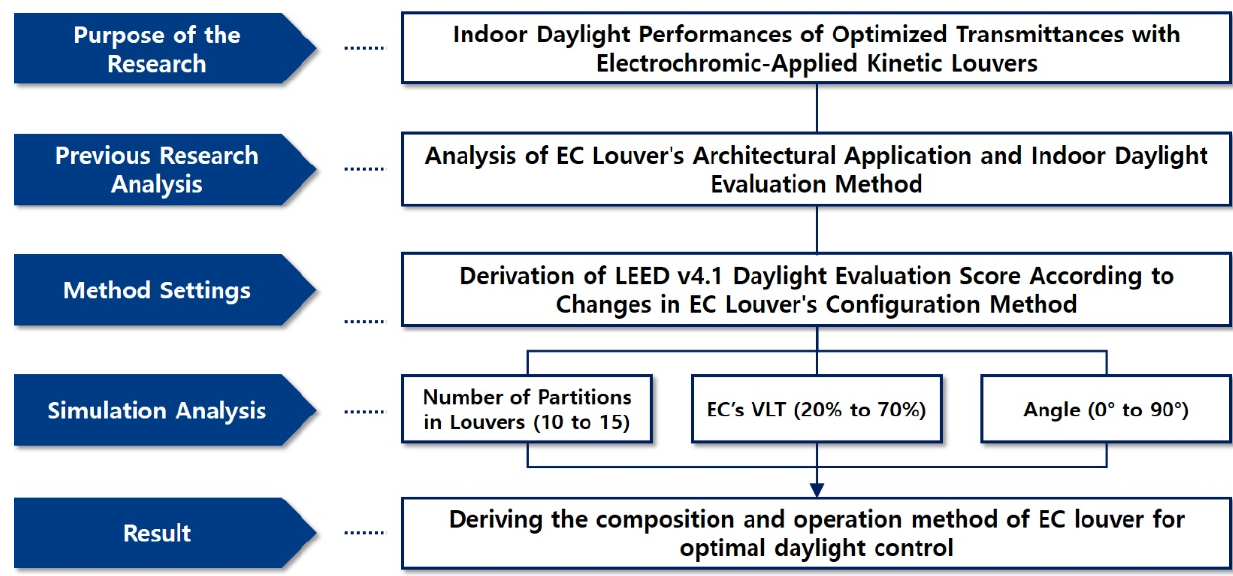
Figure 1. Research flowchart and research scope.